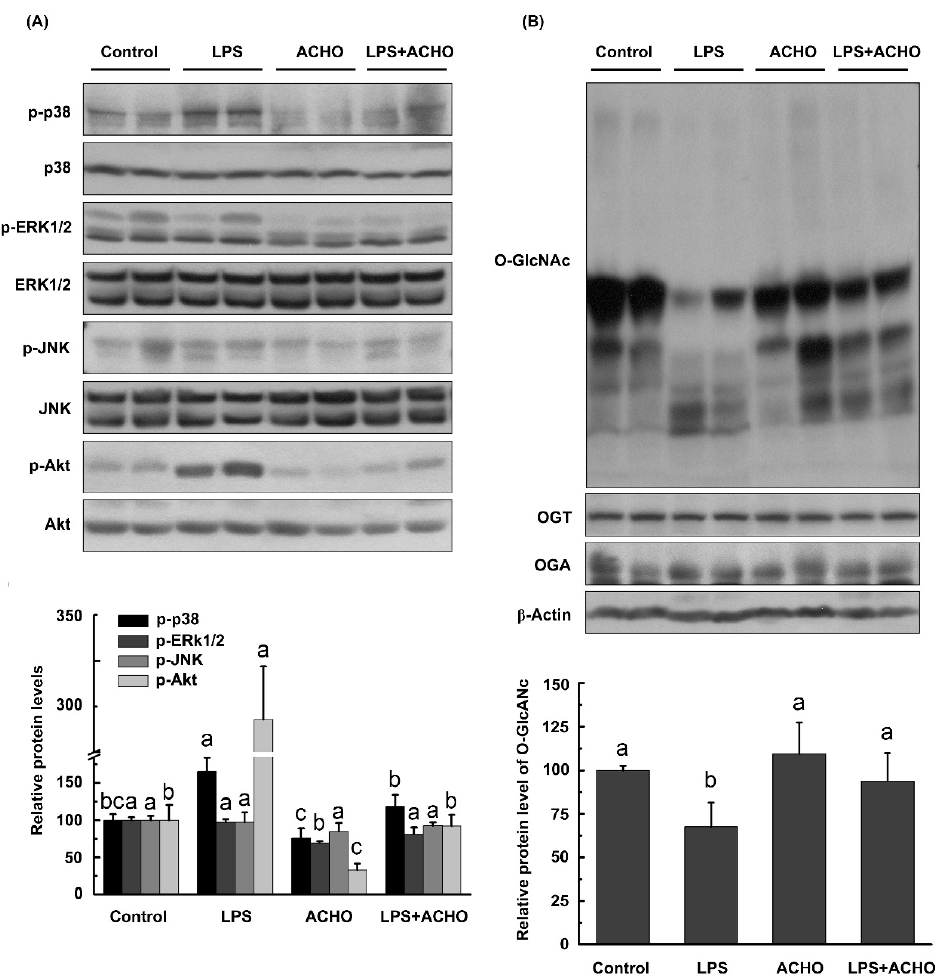
Figure 6. Effect of ACHO on MAPKs, Akt and protein O -GlcNAcylation in the lung tissues of LPS-injected mice. ( A ) Suppression of ACHO on the activation of MAPKs and Akt in lung tissues after LPS injection; ( B ) Reversal of ACHO on the decrease in protein O -GlcNAcylation in lung tissues after LPS injection. C57BL/6 mice were pre-treated with ACHO (1 mg/mL in drinking water) for two weeks followed by LPS injection (3 mg/kg) intraperitoneally for 24 h. After that, mice were euthanized, and lung tissues were collected for western blot assay. Data represent the mean ± SD ( n = 5). Data with different superscript letters are significantly different ( p < 0.05).